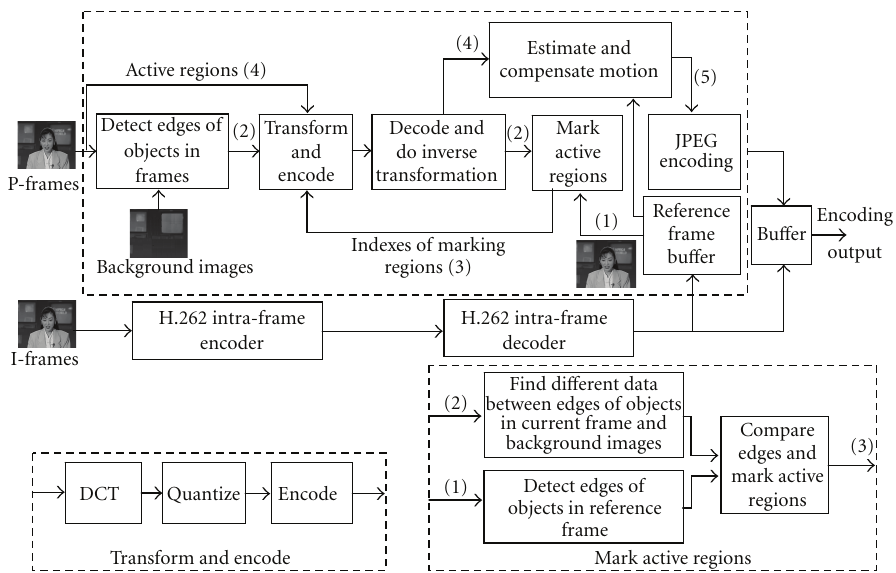
Figure 9: The proposed video compression scheme 2.